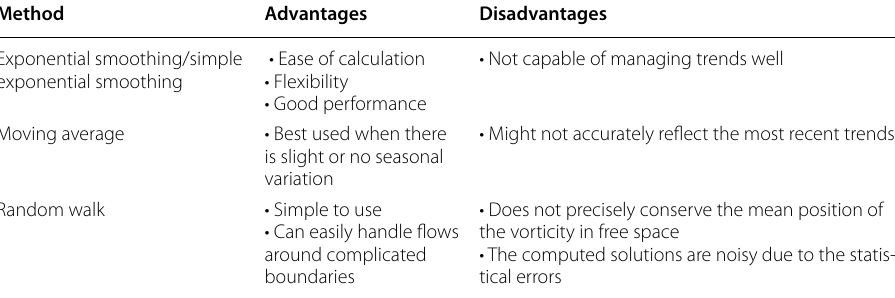
Table 1 Types of data